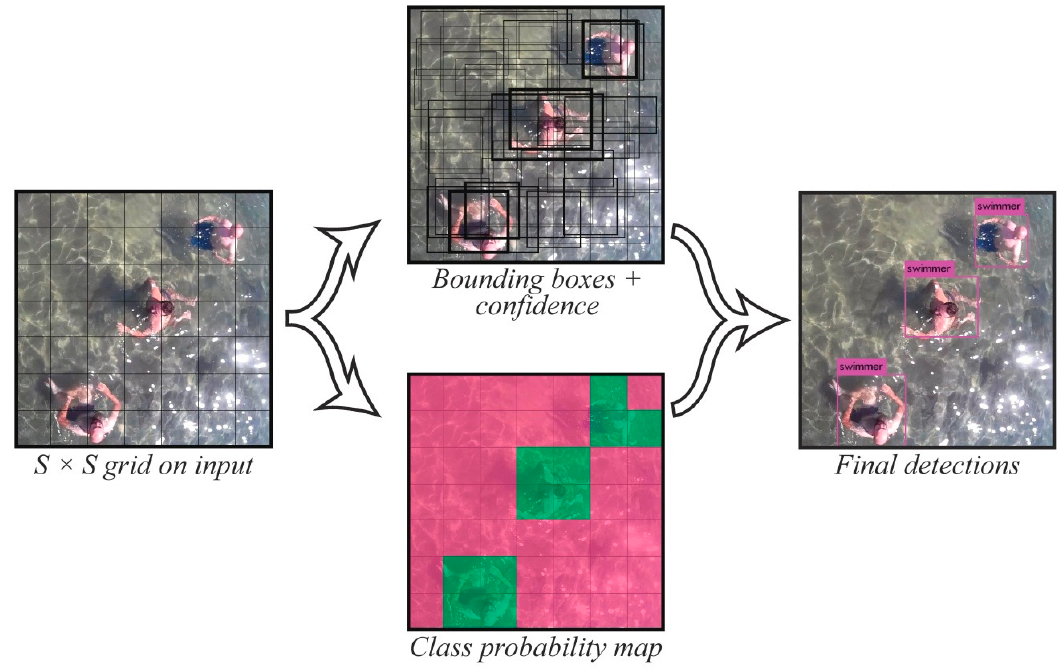
Figure 1. Image captured by the rescue unmanned aerial vehicle (UAV): (Left) divided into equally S × S sized grid cells, (Top and Bottom) predicting B bounding boxes, confidence scores and C conditional class probabilities, (Right) leading to final encoded detections.